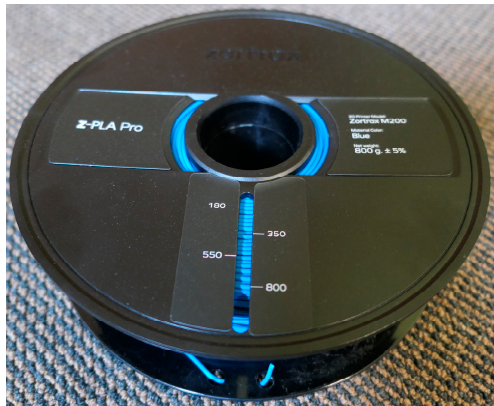
Figure 3. The filament used during the tests—producer ZORTRAX company, the diameter 1.75 mm.